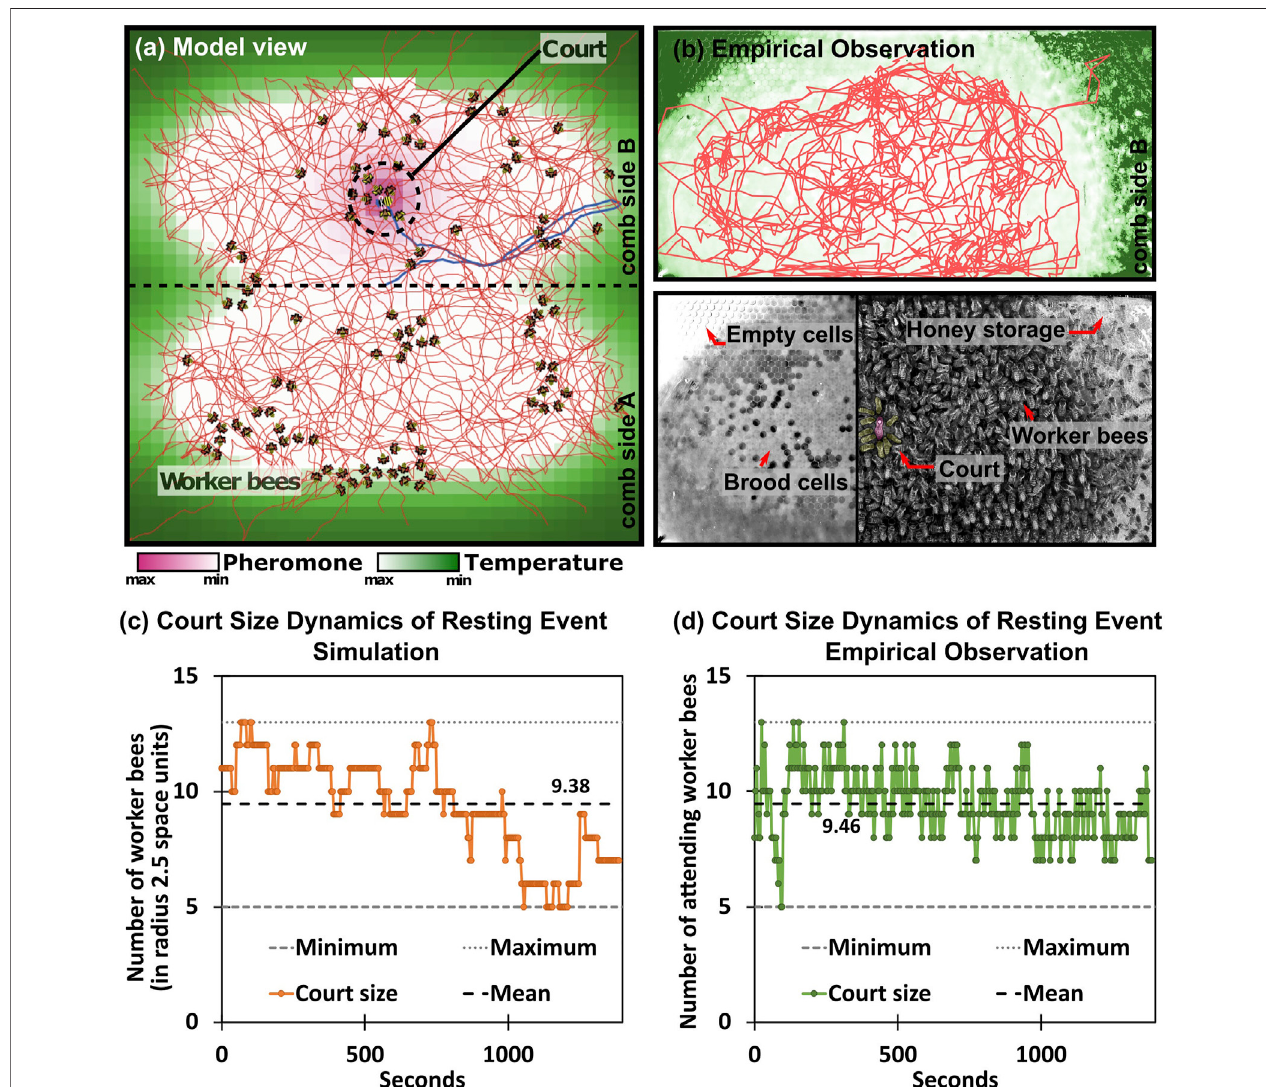
FIGURE 4 | General model overview. (A) Spatial representation of the queen-court-broodnest system in our model. Shades of green indicate the underlying static temperature gradient in and around the brood nest area of the comb. We modeled two comb sides, the place of potential crossing between comb sides is indicated by thecentralhorizontalline.Shadesofpurpleshowthepheromonegradientemittedbythequeen,linesindicateagentmovementpatterns. (B) Uppersub- fi gure:Empirical observation of queen movement pattern (red line) over the course of 6 h in an observation hive, shades of green indicate the area of the brood nest that normally corresponds to a temperature gradient. Lower sub- fi gure, left: Underlying honeycomb structure made visible by computer-assisted removal of moving bees in the foreground,lightcellsinthecenterofthehoneycombrepresentcappedbroodcells;right:imagetakenfromanobservationhivewithhighlightedqueenandqueen-court (C,D) Emergingqueen-courtsizedynamicsduringanexemplaryqueenrestingeventinthemodel (C) andempiricallyobserved (D) overthecourseof1,400 s,courtsize varies between 5 and 13 worker bees with an arithmetic average of 9.38 bees (model), and 9.46 bees (observation).